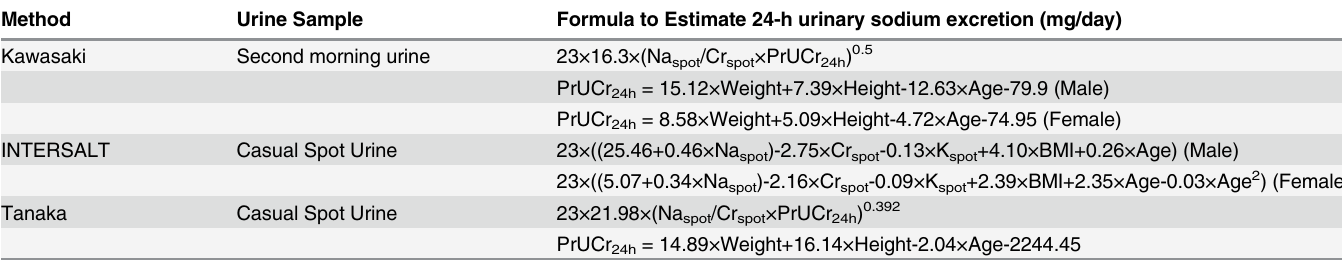
Table 1. Three methods to estimated 24-hour urinary sodium